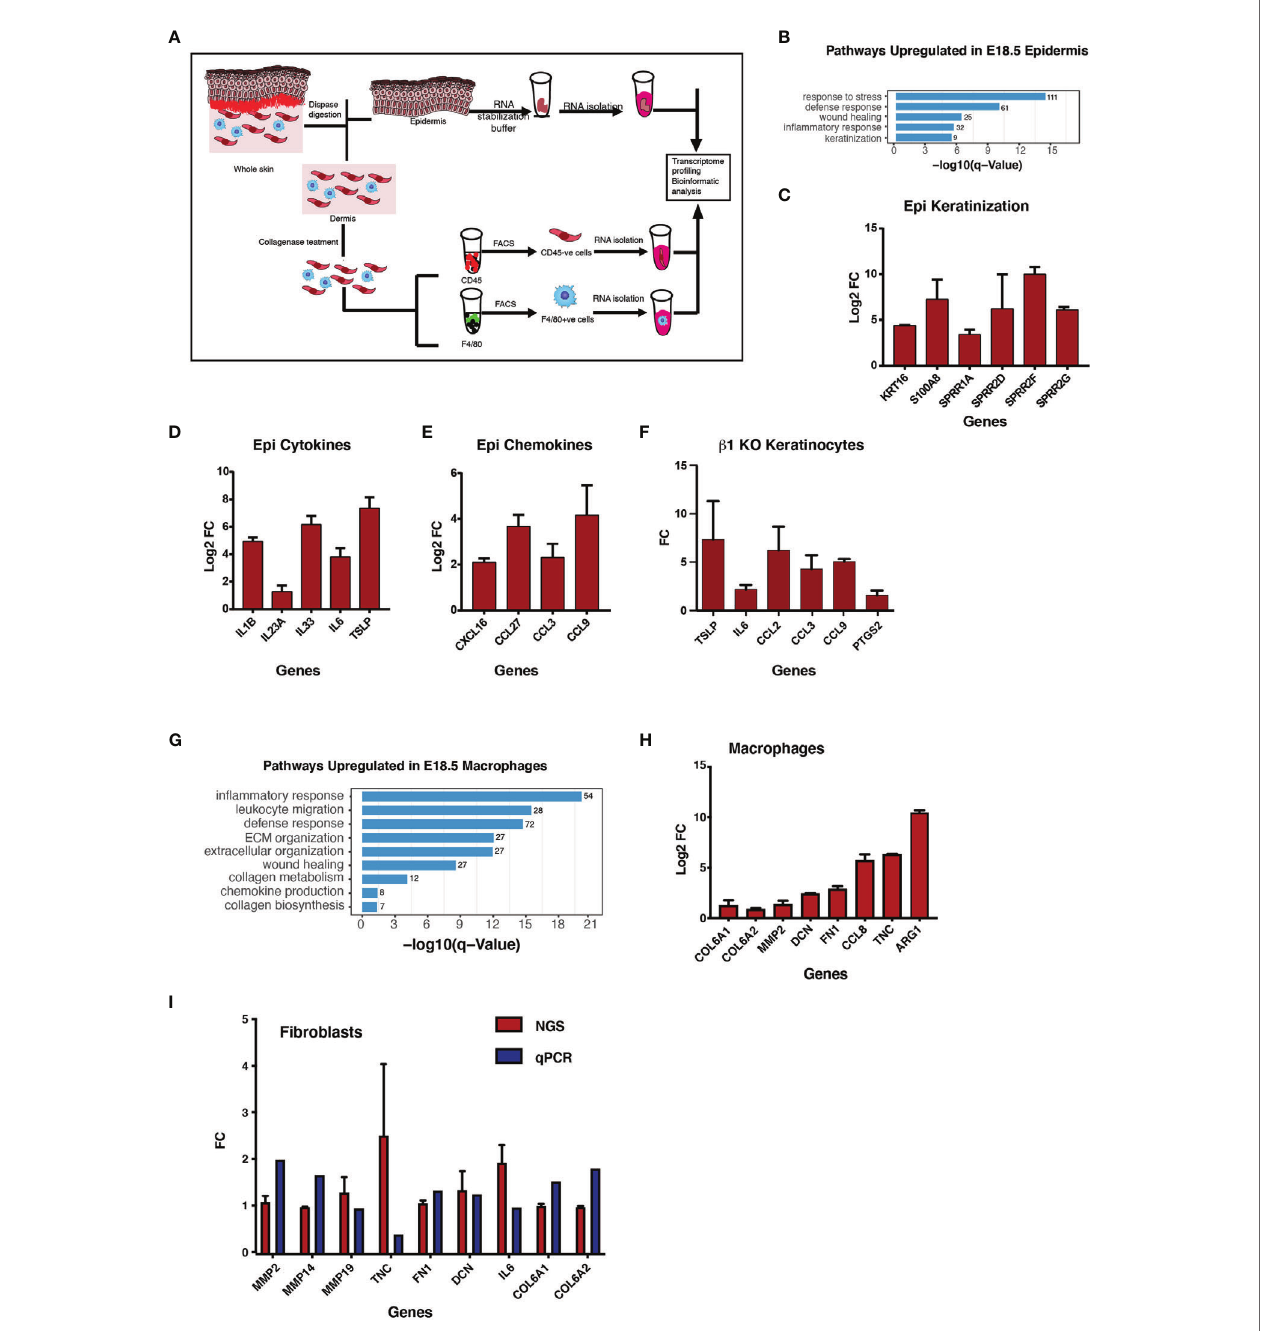
FIGURE 2 | Increased expression of the proin fl ammatory cytokines in the epidermis and increased expression of ECM transcripts in macrophages in the KO skin. Graphical illustration of the steps involved in the isolation of epidermis, fi broblasts and macrophages to perform RNA sequencing analysis at E18.5 (A) . Gene Ontology analyses of pathways upregulated in the epidermis E18.5 tg b 1 epidermal KO skin (B) (N=2). Real-time qPCR for the cytokines, chemokines and the keratinization genes expressed in the KO epidermis at E18.5 compared to the control (C – E) (N=2). Fold changes in the control are normalized to 1. Real-time qPCR for the cytokines and chemokines upregulated in the b 1 KO keratinocytes (F) (N=2). Gene Ontology analyses of pathways upregulated in the macrophages in the E18.5 KO skin (G) . Real-time qPCR for the ECM transcripts expressed in the macrophages in the tg b 1 epidermal KO skin compared to the control (H) (N=2). Fold changes in the control are normalized to 1. Bar graphs representing ECM transcripts expressed in the fi broblasts in the E18.5 KO skin (I)